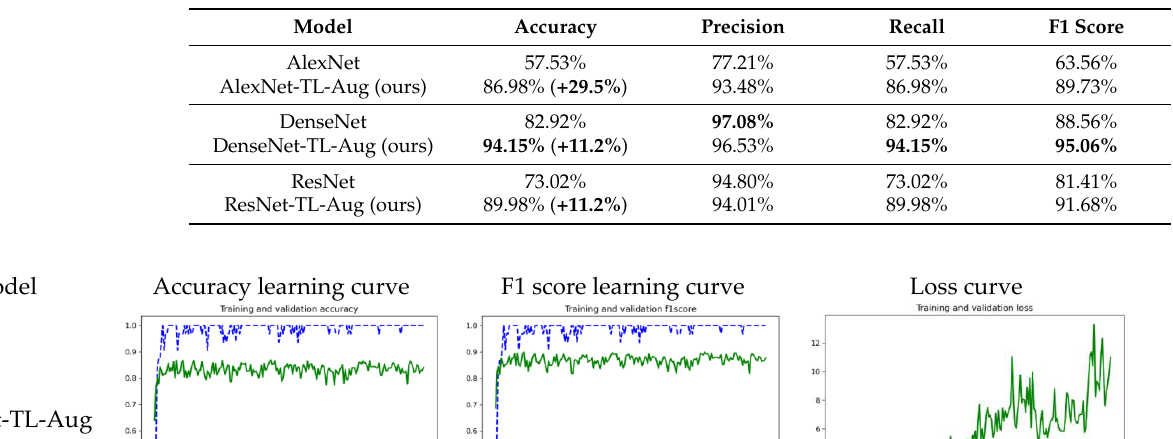
Table 5. Performance comparison of the proposed networks with transfer learning and AutoAugment and baselines on the test set. The best metrics are highlighted in bold font.